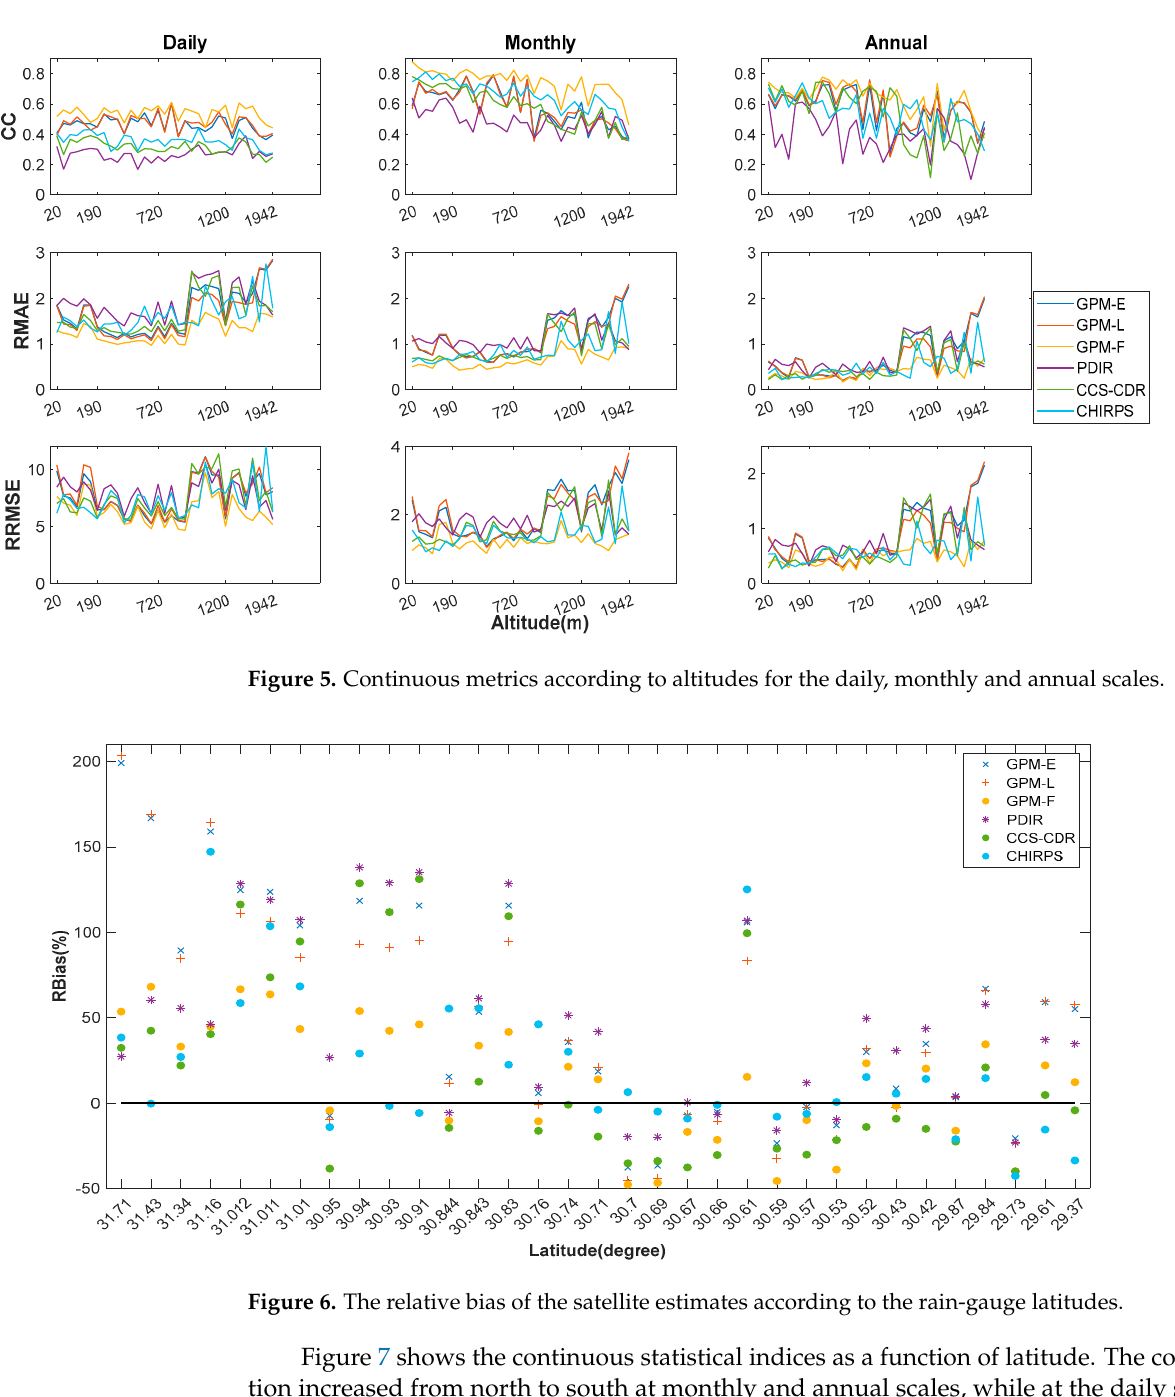
Figure 6. The relative bias of the satellite estimates according to the rain-gauge